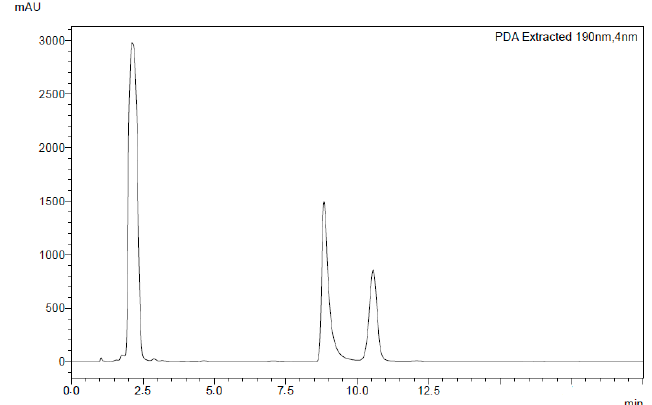
Figure 6. Chromatogram obtained from the injection of the microemulsion using the developed HPLC method. Table 3. Data related to the repeatability and intermediate precision of the developed HPLC method.